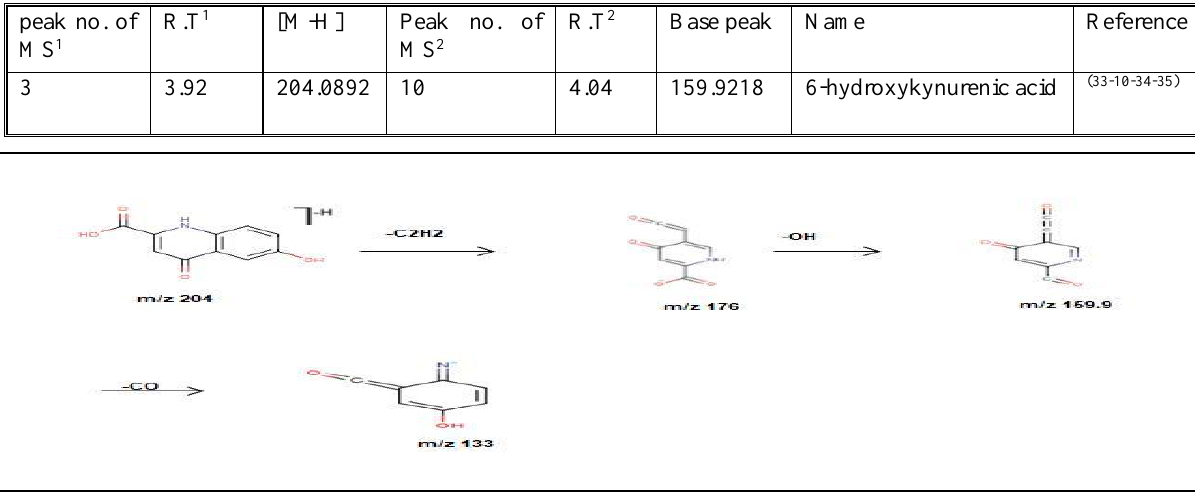
Figure 18. Structural elucidations of AS2 fragmentations (33) .